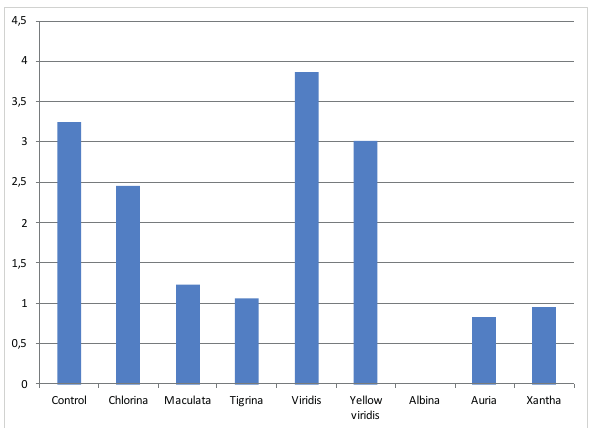
Figure 5. Chlorophyll content in normal type and chlorophyll defi- cient mutants of Artemisia annua L.